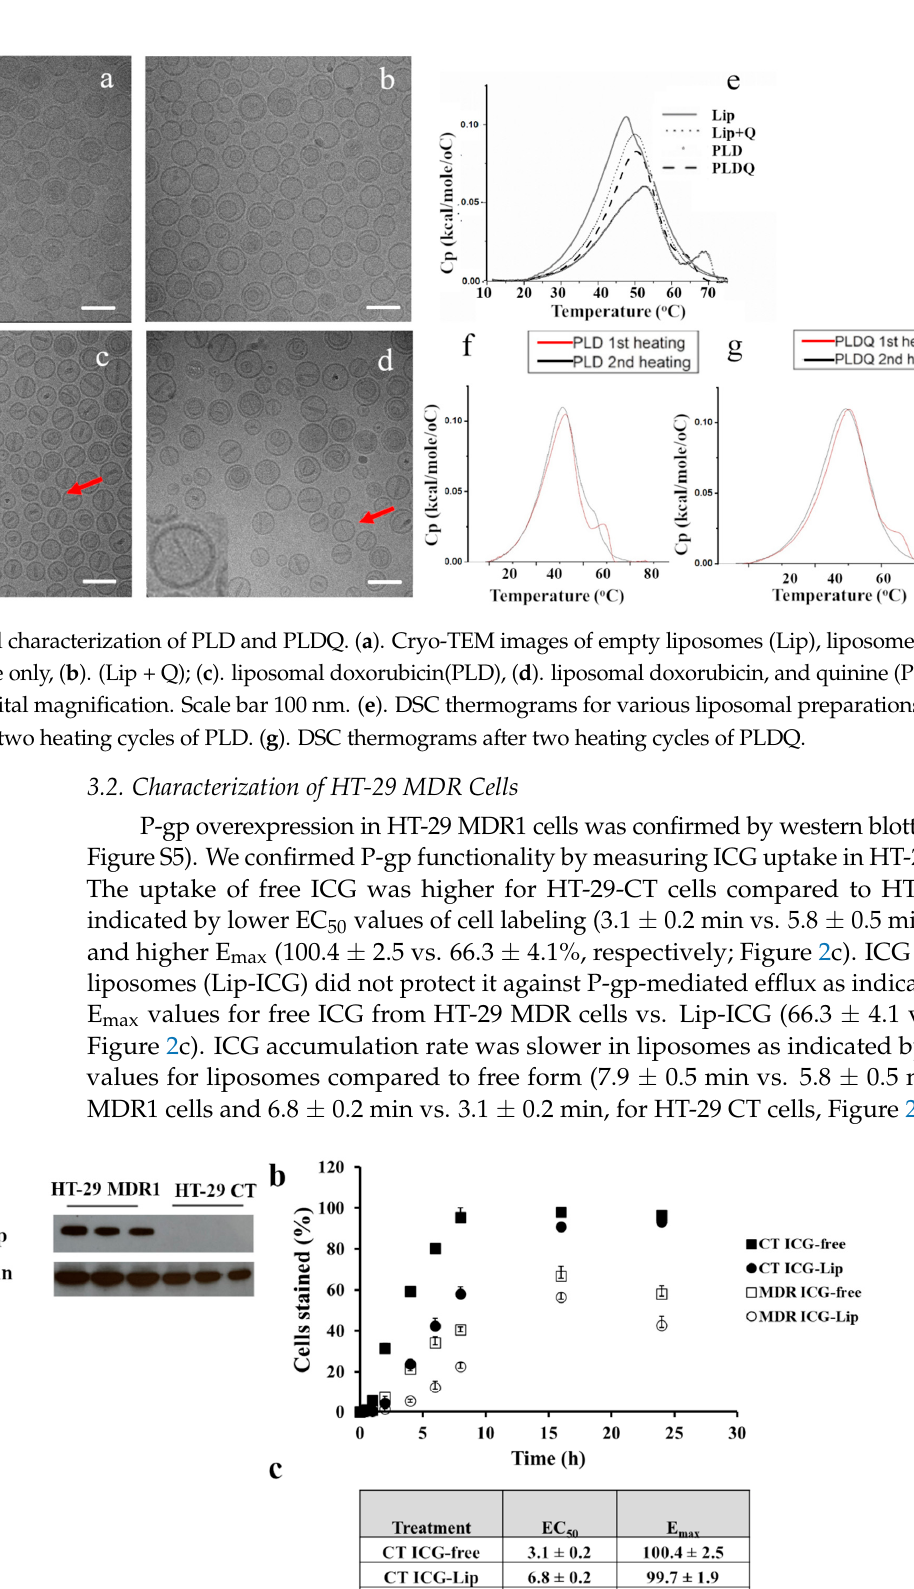
Figure 3. Toxicity of doxorubicin and ICG in HT-29 CT and HT-29 MDR1 cells with and without NIR irradiation. ( a ). Survival (%) HT-29 MDR1 cells treated by free ICG and doxorubicin. ( b ). Survival (%) HT-29 CT cells treated by free ICG or doxorubicin. ( c ). Analysis of area under the curve (AUC) of toxicity curves in HT-29 CT cells, based on Figure 2b. ( d ). Survival (%) HT-29 MDR1 cells treated by liposomal ICG and doxorubicin. % Survival normalized to control untreated cells. 2-way ANOVA Tukey Multiple Comparisons Test n = 6. The filled and open markers represent non-irradiated and irradiated cells, respectively. * compared to ICG, not irradiated, ** compared to ICG, irradiated. Values represent mean ± SD. 3.4. Cytotoxicity Measurements of Free and Liposomal Drugs in HT-29 MDR1 Cells in the Presence of P-Gp Inhibitor Quinine Free quinine, doxorubicin, and ICG were not toxic to either in irradiated or non- irradiated form for free drugs (~20% compared to untreated cells, Figure 4a). At the same